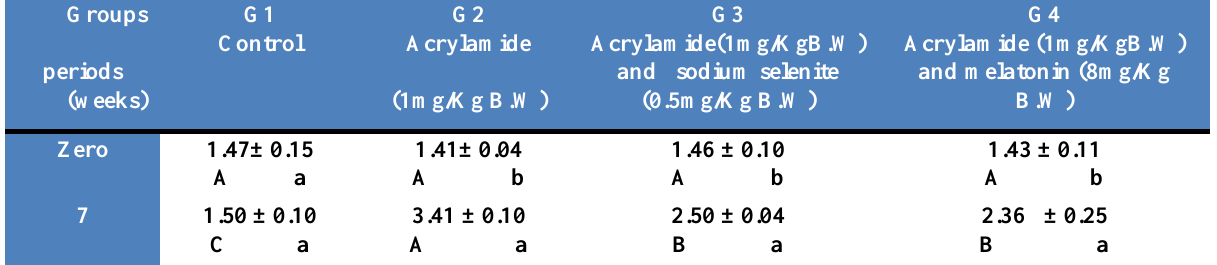
time. Different capital letters represent a significant difference between groups (P<0.05) vs. control. Table, 5: Effect of sodium selenite on serum uric acid concentration (mg/dl) in acrylamide treated rats. Groups